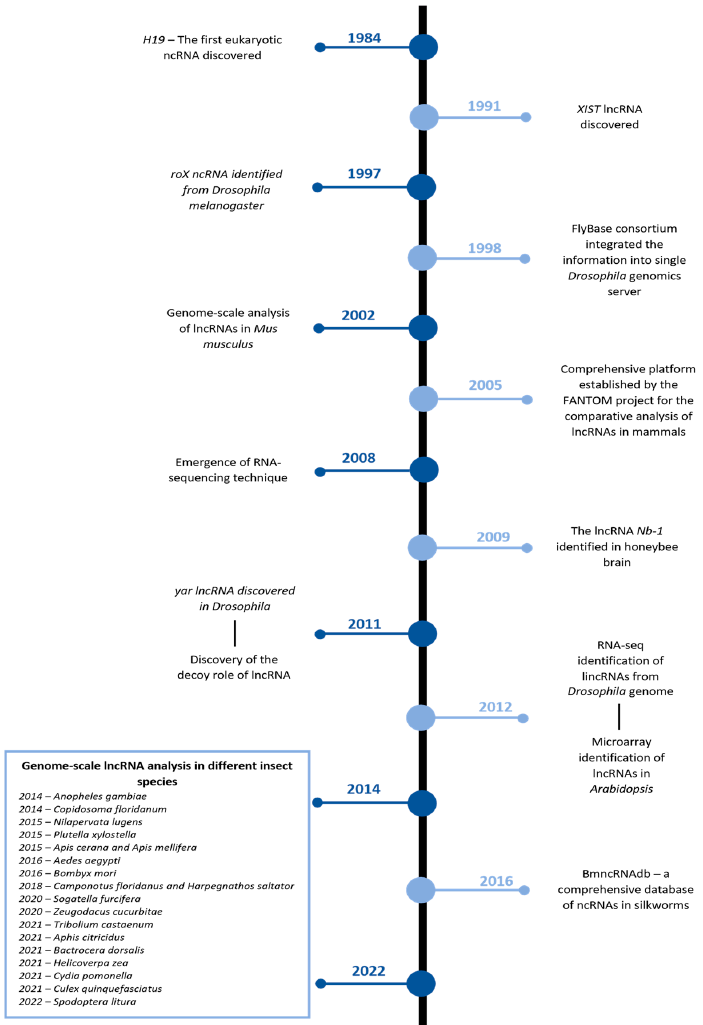
Figure 1. Some of the significant developments in long non-coding RNA research. Note: lncRNA denotes long non-coding RNA; roX denotes RNA-on-X; XIST denotes X-inactive-specific transcript; Nb-1 denotes Nurse bee brain-selective gene-1; yar denotes yellow-achaete intergenic RNA; and lincRNA denotes long intergenic non-coding RNAs.